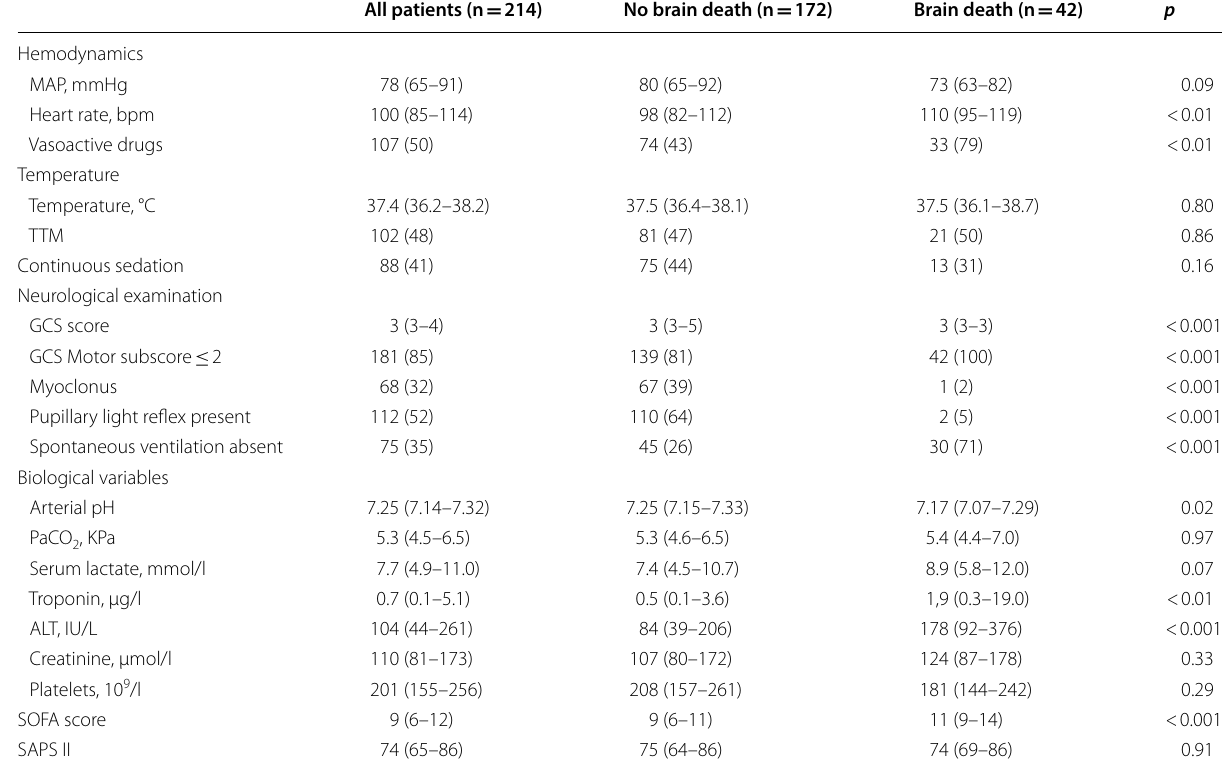
Data are expressed as median (interquartile range) or number (%)